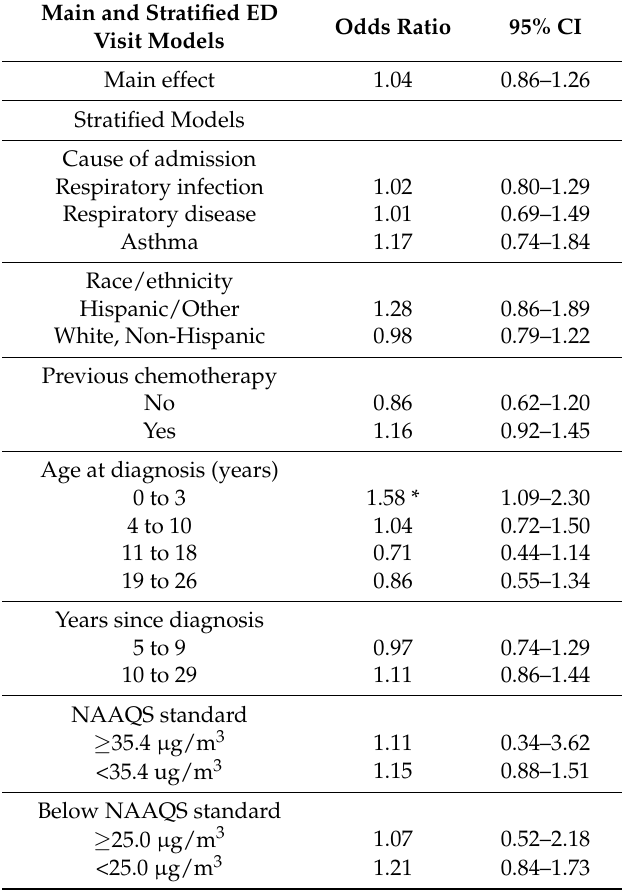
Table 4. Odds ratios and 95% confidence intervals (CI) for the main and stratified effects of a 10 µ g/m 3 increase in PM 2.5 with respiratory emergency department (ED) visits among survivors of childhood cancers.